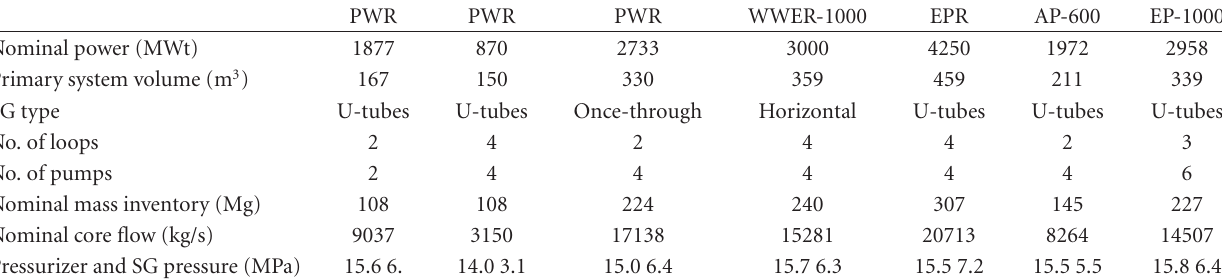
Table 2: Relevant characteristics of NPP considered for the application of the NCFM.